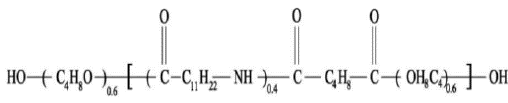
Fig. 1. Chemical structure of PEBAX-1657 [10].